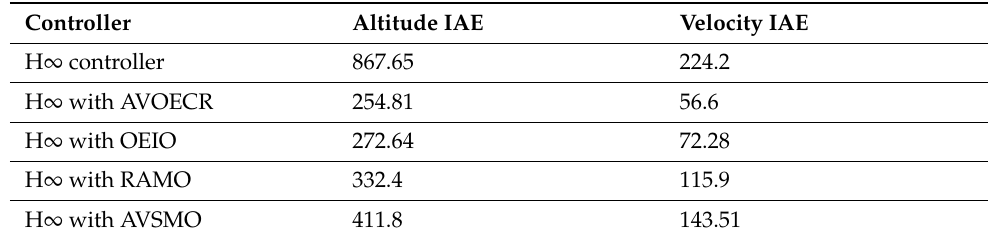
Table 5. Trajectory tracking IAE comparison of the observer-based disturbance rejection controllers based on H ∞ control for the climb-cruise land flight